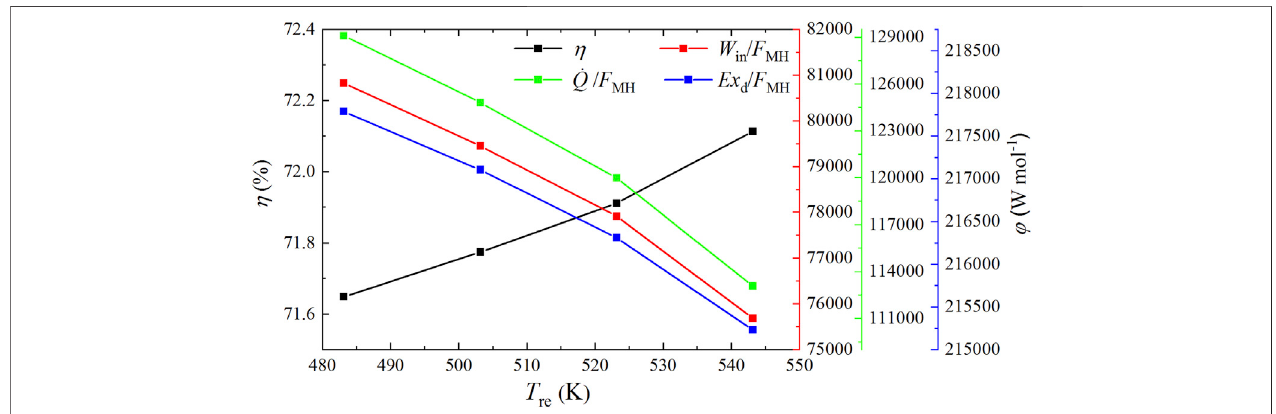
FIGURE 7 | Input power, cold energy, and exergy destruction per molar synthetic methanol and exergy ef fi ciency under different reaction temperatures.